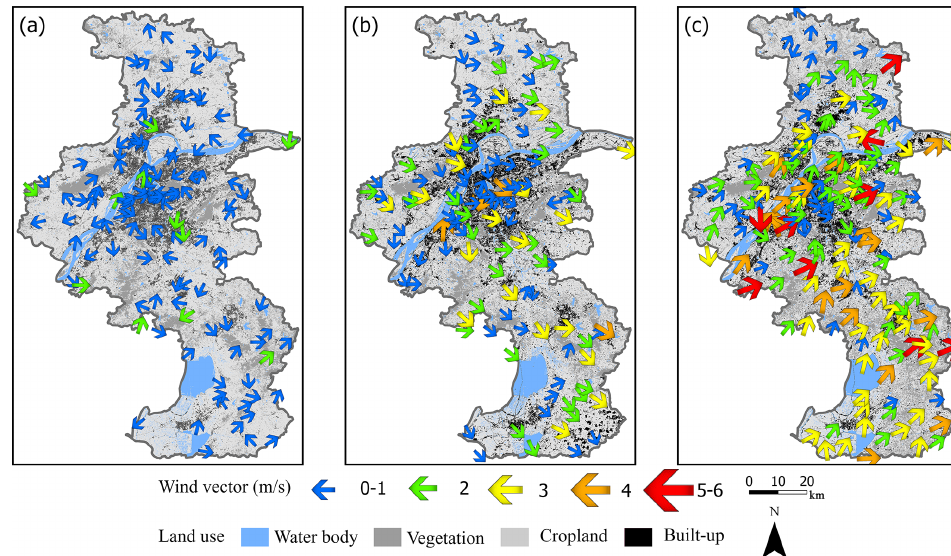
Figure 11. Wind vector field in Nanjing on (a) 11 August 2013, (b) 2 September 2015, and (c) 21 July